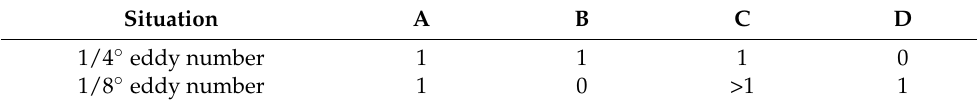
Table 2. Resulting from four different situations of eddy matching.